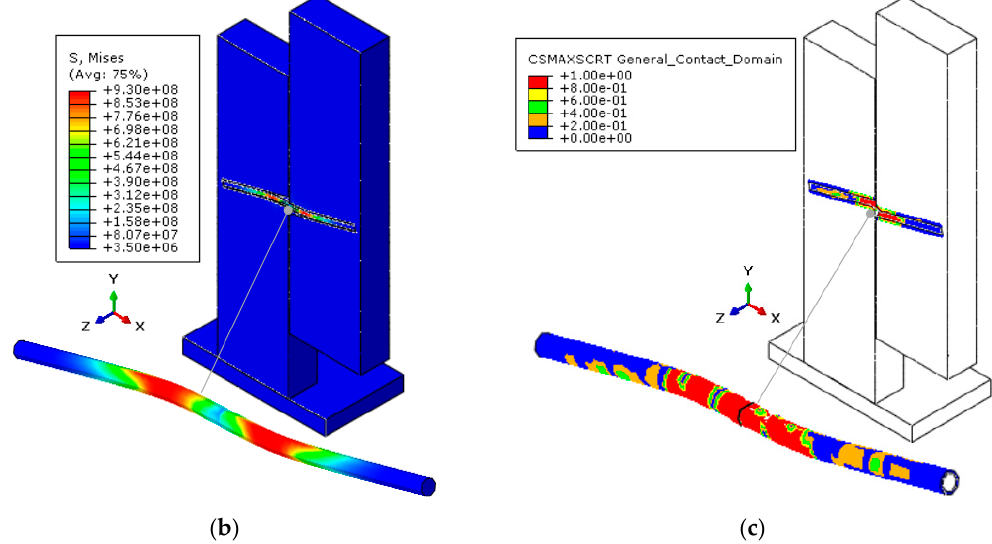
Figure 9. Typical damage propagation in the selected TTC joints with inclined STSs, under a standard PO setup (ABAQUS/Explicit). Example for the S#1 specimen with α = − 15°, with evidence of: ( a ) local damage of timber (stress values in Pa), ( b ) yielding of screws (stress values in Pa) and ( c ) CZM damage parameter. Reproduced from [21] with permission from Elsevier ® , Copyright license number 4895820420991, August 2020.